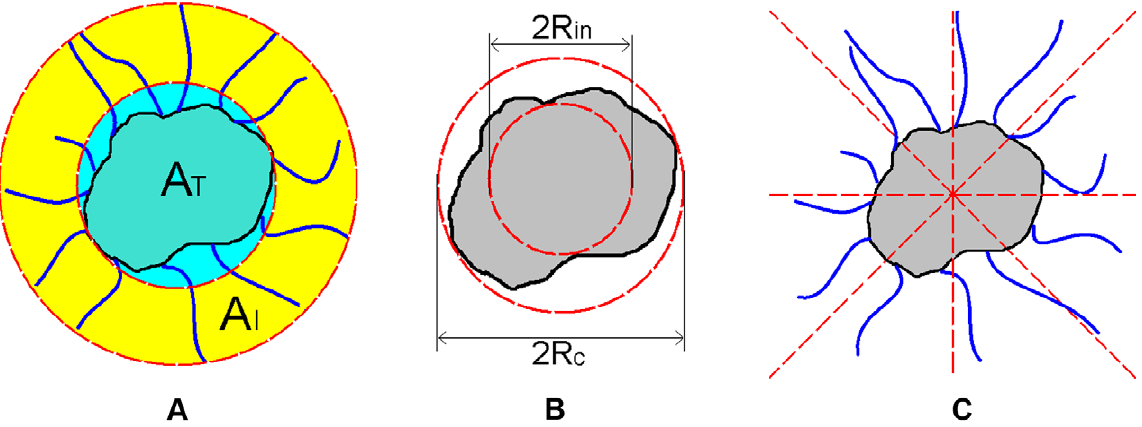
Figure 4. Schematic illustration of the quantities in the definitions of tumor morphology metrics. (a) Invasive area A I and tumor area A T associated with the invasive pattern. (b) Circumcircle with radius R c and incircle with radius R in associated with the primary tumor. (c) Evenly dividing the invasive pattern into n a ~ 8 sectors for computing the angular anisotropy metric y .